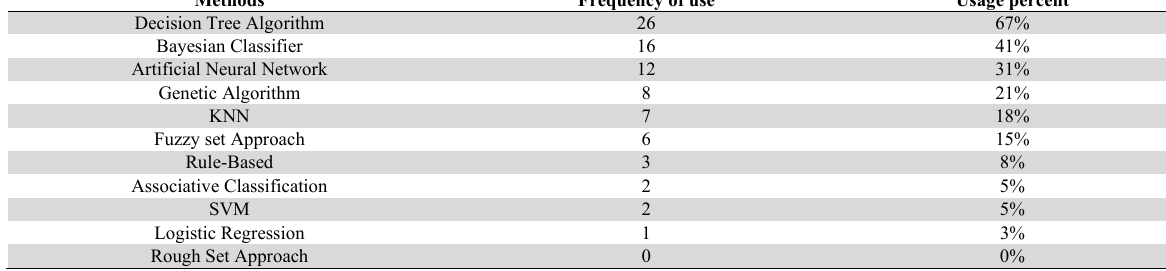
Comparison of the classification methods